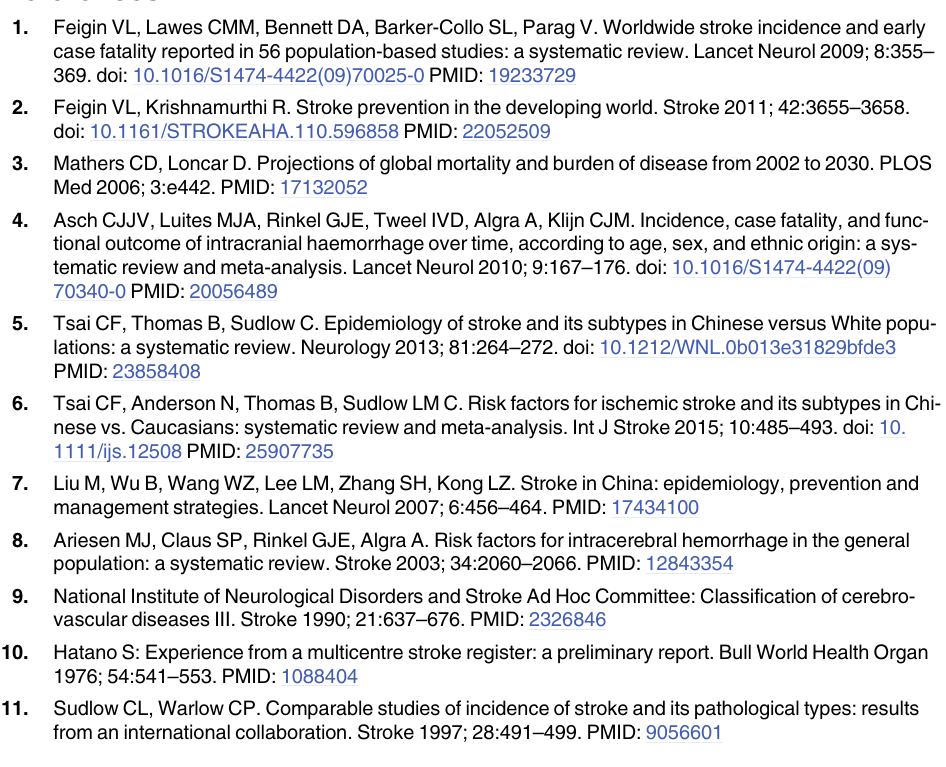
S1 Table. Definitions of risk factors. S2 Table. Risk of bias assessment for included studies (Newcastle-Ottawa scale). S3 Table. PRISMA checklist. S4 Table. Subgroup